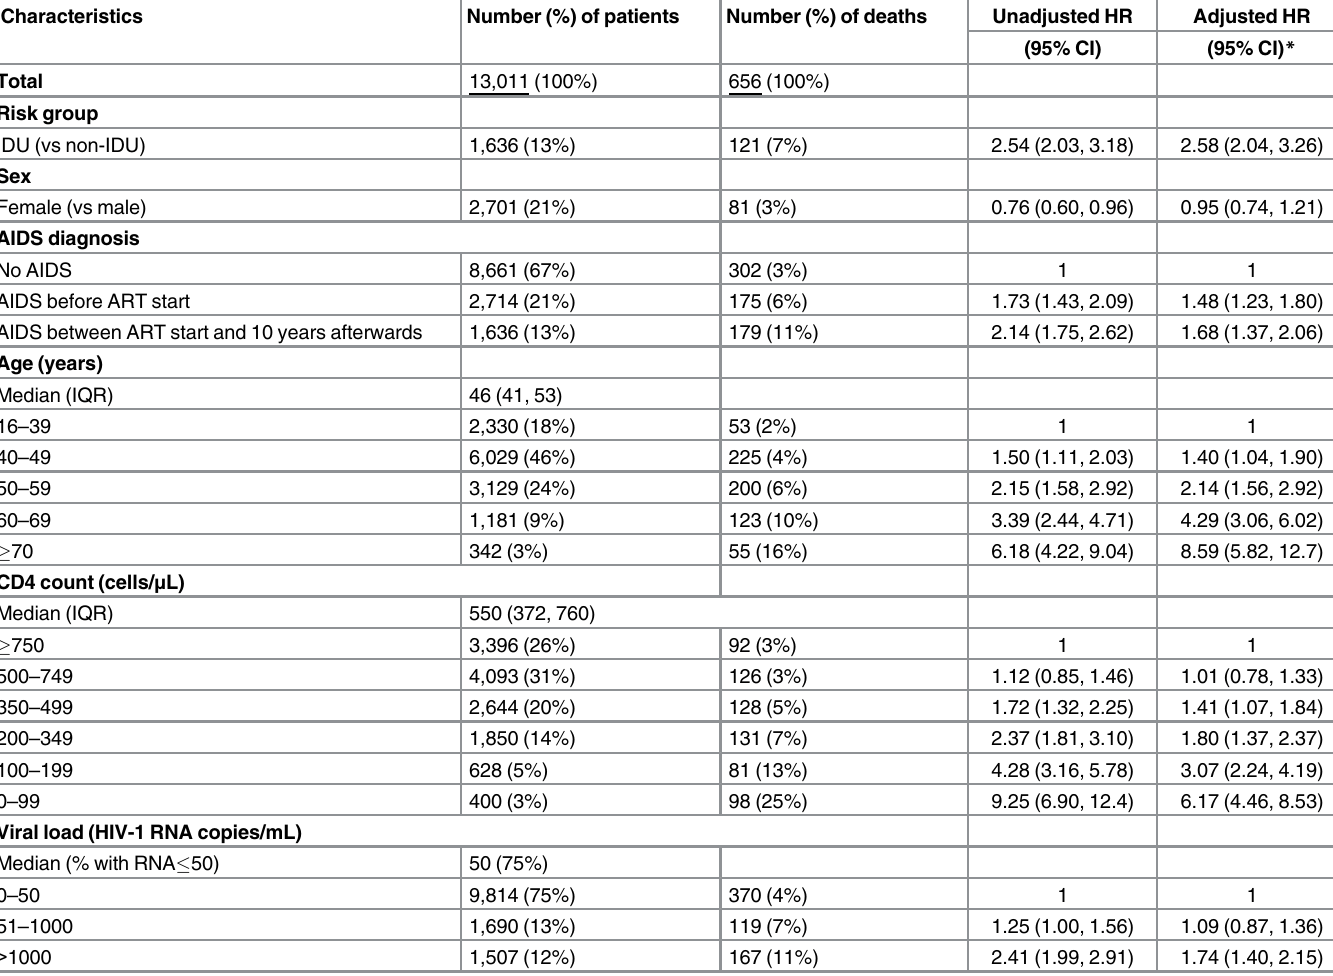
Table 3. Characteristics of eligible patients 10 years after start of ART, together with unadjusted and adjusted hazard ratios (HR). Characteristics